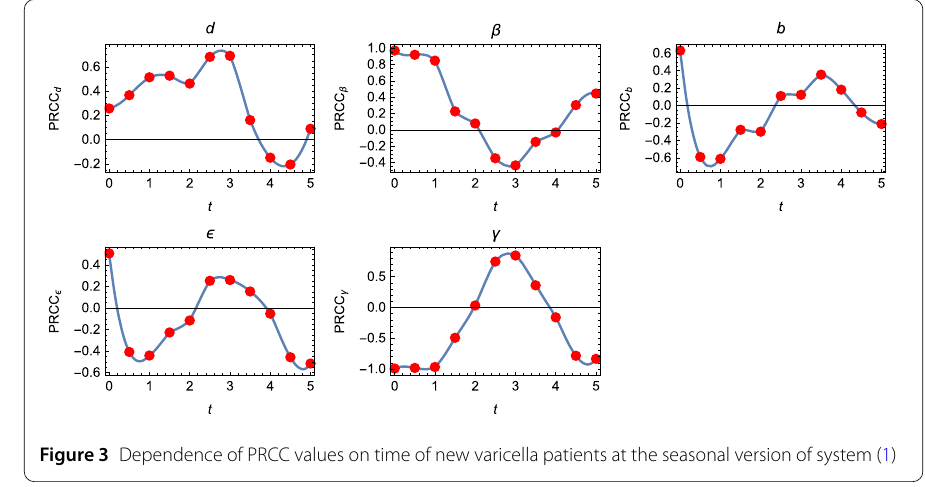
Figure 3 Dependence of PRCC values on time of new varicella patients at the seasonal version of system (1)